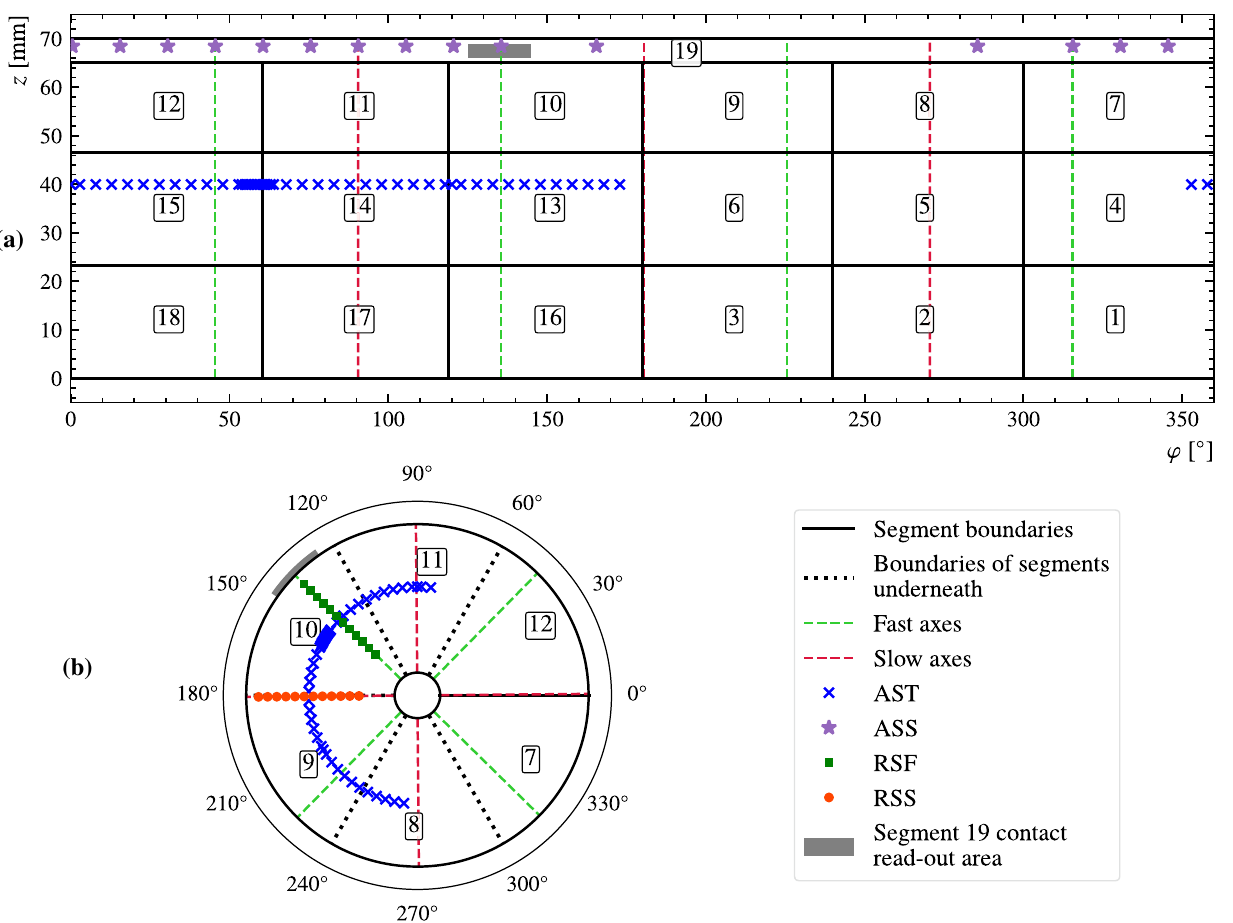
shown are the crystal axes in a and b . The framed numbers denote the segments numbers, in b for the segments underneath segment